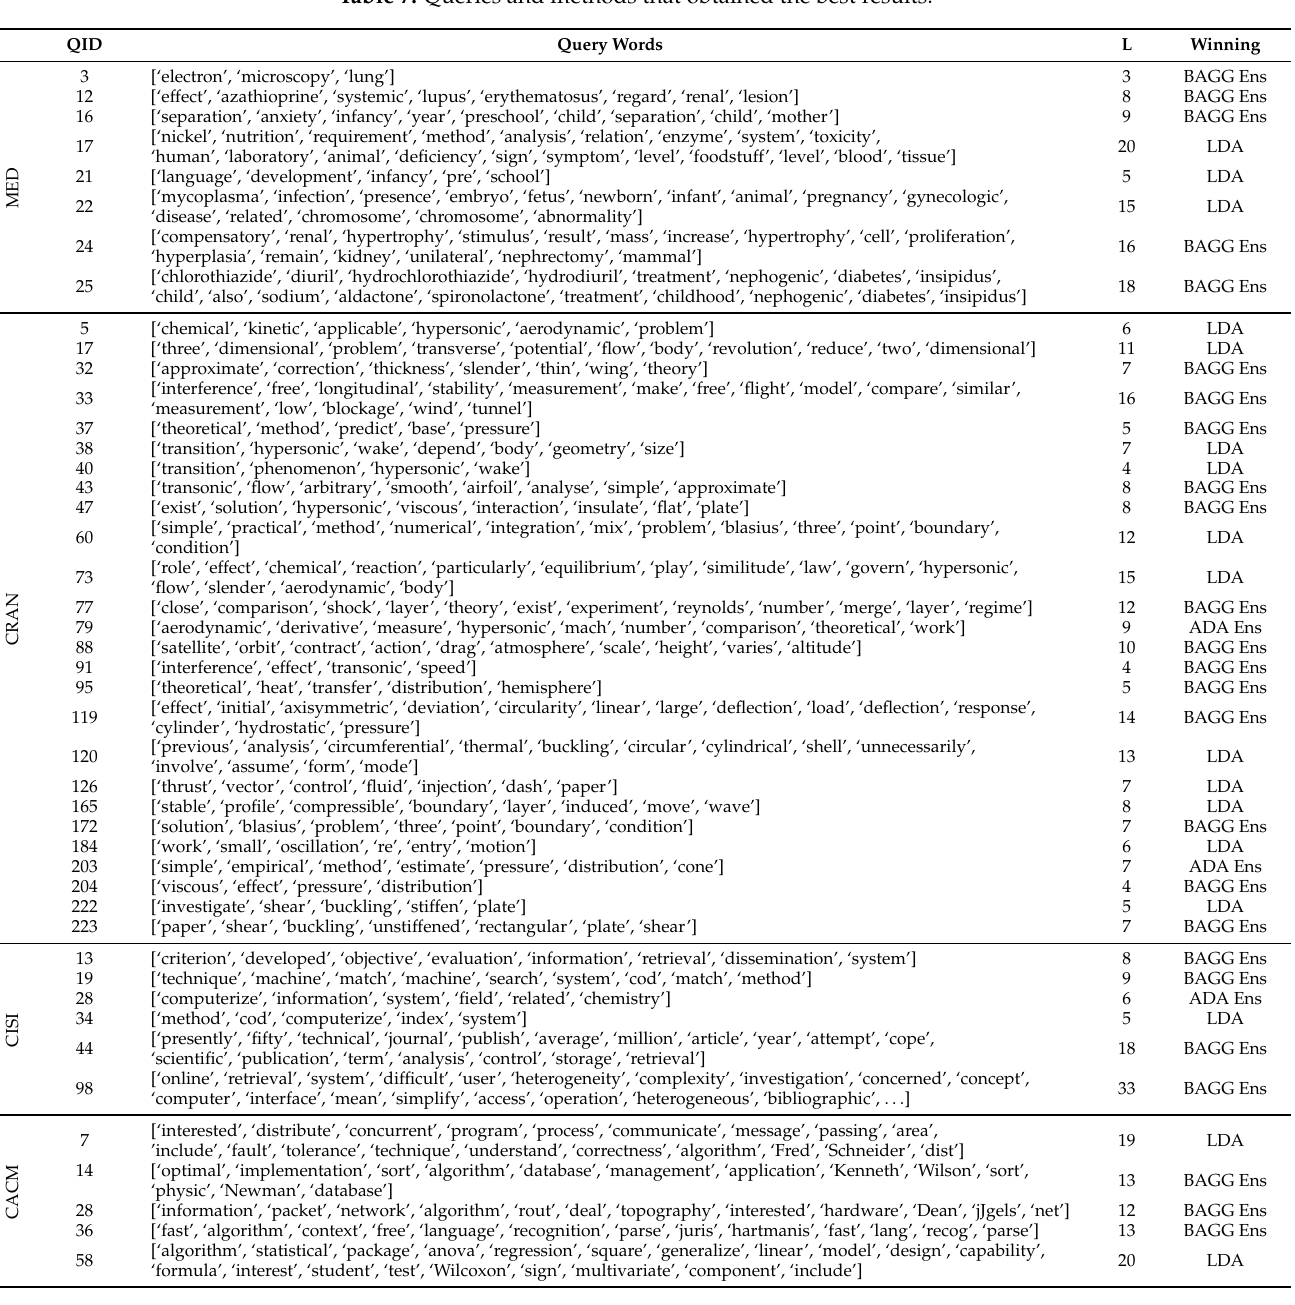
Table 7. Queries and methods that obtained the best